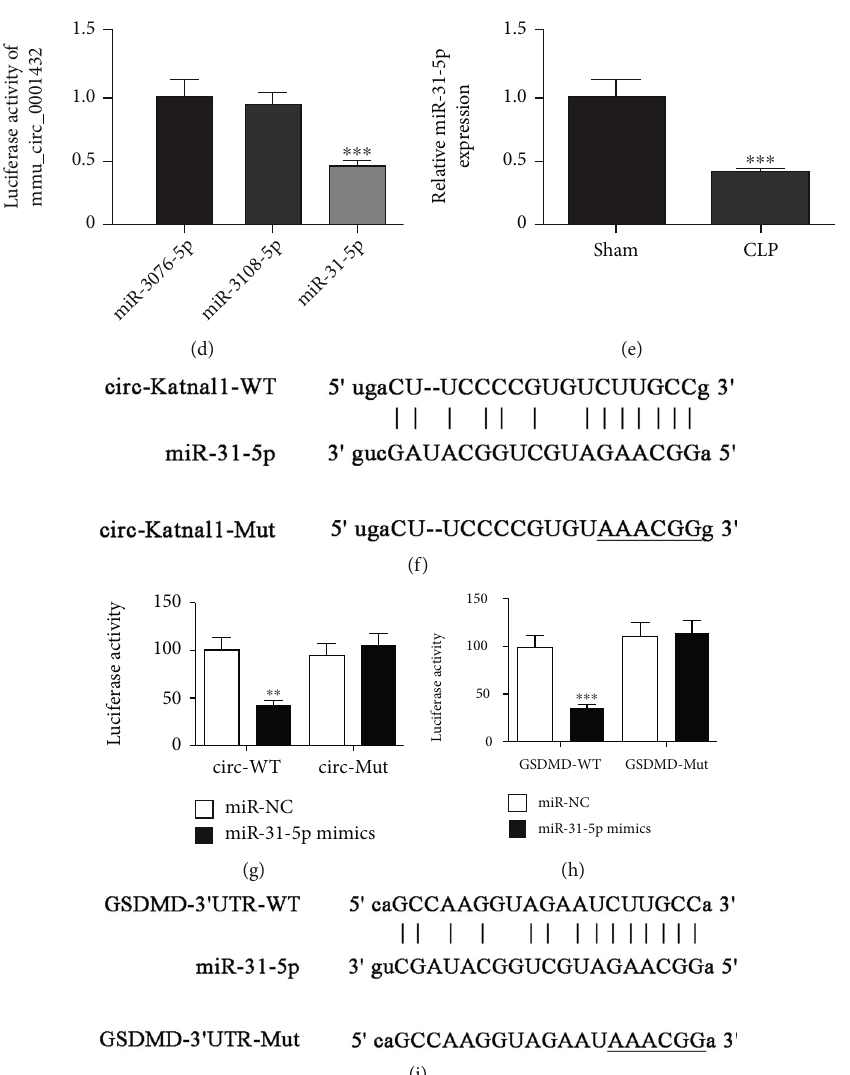
Figure 2: Abnormal expression of circ-Katnal1 played an important role in CLP-induced sepsis. (a) Heat map showing the expression of circRNA following 12-h induction after CLP in liver tissues. (b) RT-qPCR detection showed the expression of mmu_circ_0012734, mmu_circ_0001432, mmu_circ_0012767, mmu_circ_0012771, and mmu_circ_0012774 in normal and CLP-induced mouse liver tissues. Data were presented as mean ± SD . ∗∗∗ P < 0 : 001 , versus the sham group. (c) Genomic loci of the Katnal1 gene and mmu_circ_0001432 (circ-Katnal1). (d) The luciferase activity of circ-Katnal1 in HEK293 T cells transfected with di ff erent miRNA mimics, which were putative binding sites for the circ-Katnal1 sequence. Luciferase activity was normalized by Renilla luciferase activity. Data were presented as mean ± SD . ∗∗∗ P < 0 : 001 . (e) RT-qPCR detection showed the expression of miR-31-5p in normal and CLP-induced mouse liver tissues. Data were presented as mean ± SD . ∗∗ P < 0 : 01 versus the sham group. (f, g) Prediction of the binding sites of miR-31-5p in circ- Katnal1. The MUT version of circ-Katnal1 is presented. The relative luciferase activity determined 48h after the transfection of HEK293 T cells with miR-31-5p mimic/NC or circ-Katnal1 WT/Mut. Data were presented as means ± SD . ∗∗ P < 0 : 01 . (h, i) Prediction of the binding sites of miR-31-5p in 3 ′ UTR-GSDMD. The MUT version of 3 ′ UTR-GSDMD is presented. Relative luciferase activity determined 48h after the transfection of HEK293 T cells with miR-31-5p mimic/NC or 3 ′ UTR-GSDMD WT/Mut. Data were presented as means ± SD . ∗∗∗ P < 0 : 001